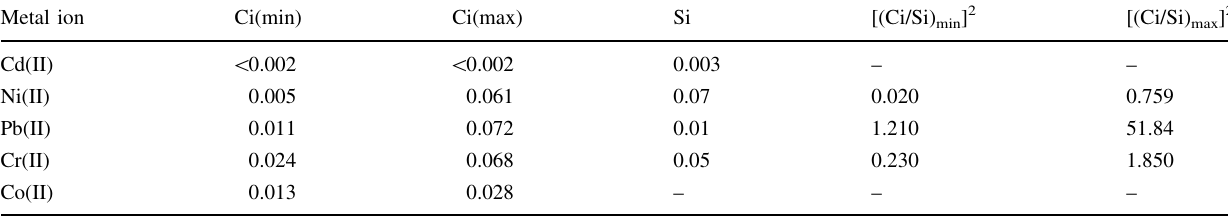
Table 5 Quantification of pollution load index from metal concentrations ( l g/mL) and WHO standard values (Si) Metal ion